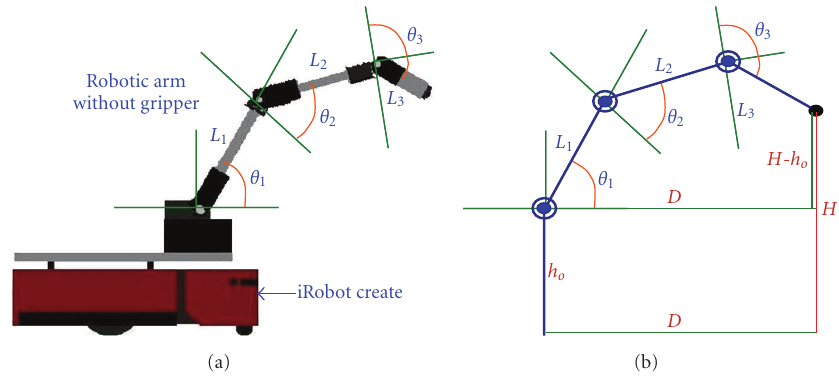
Figure 5: Arm joint angles (a) and arm joint geometric representation (b).